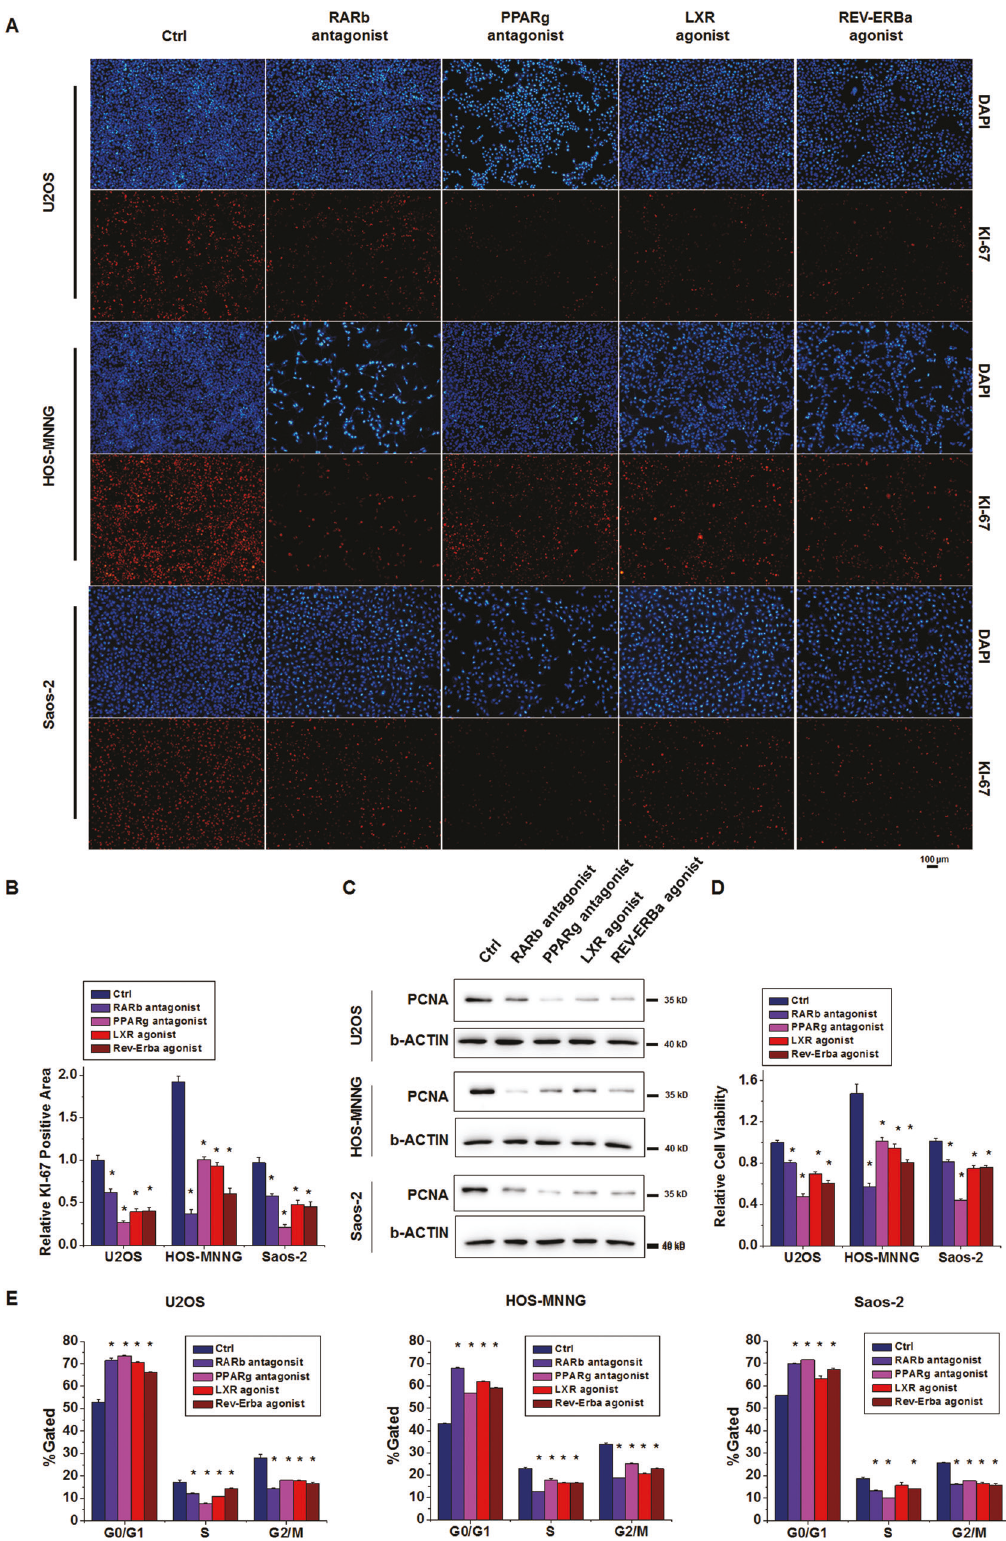
(Fig. 6A). DDIT4, HYPK and SRGN were upregulated while NPAS4 was downregulated by the treatments (Fig. 6B). Among the four genes, DDIT4 had the highest expression level in osteosarcoma cells, and its expression exhibited the greatest fold change